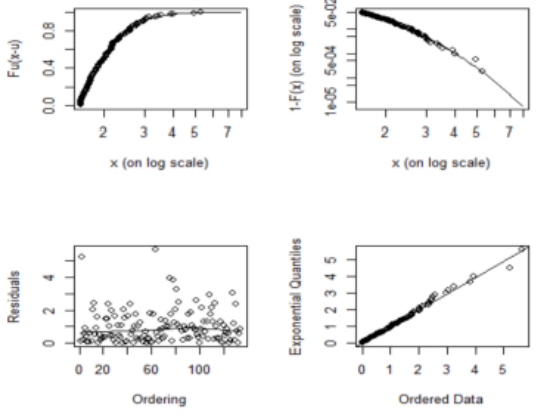
Fig. 4 HS300 Residual Sequence EVT Model Diagnosis Diagram.